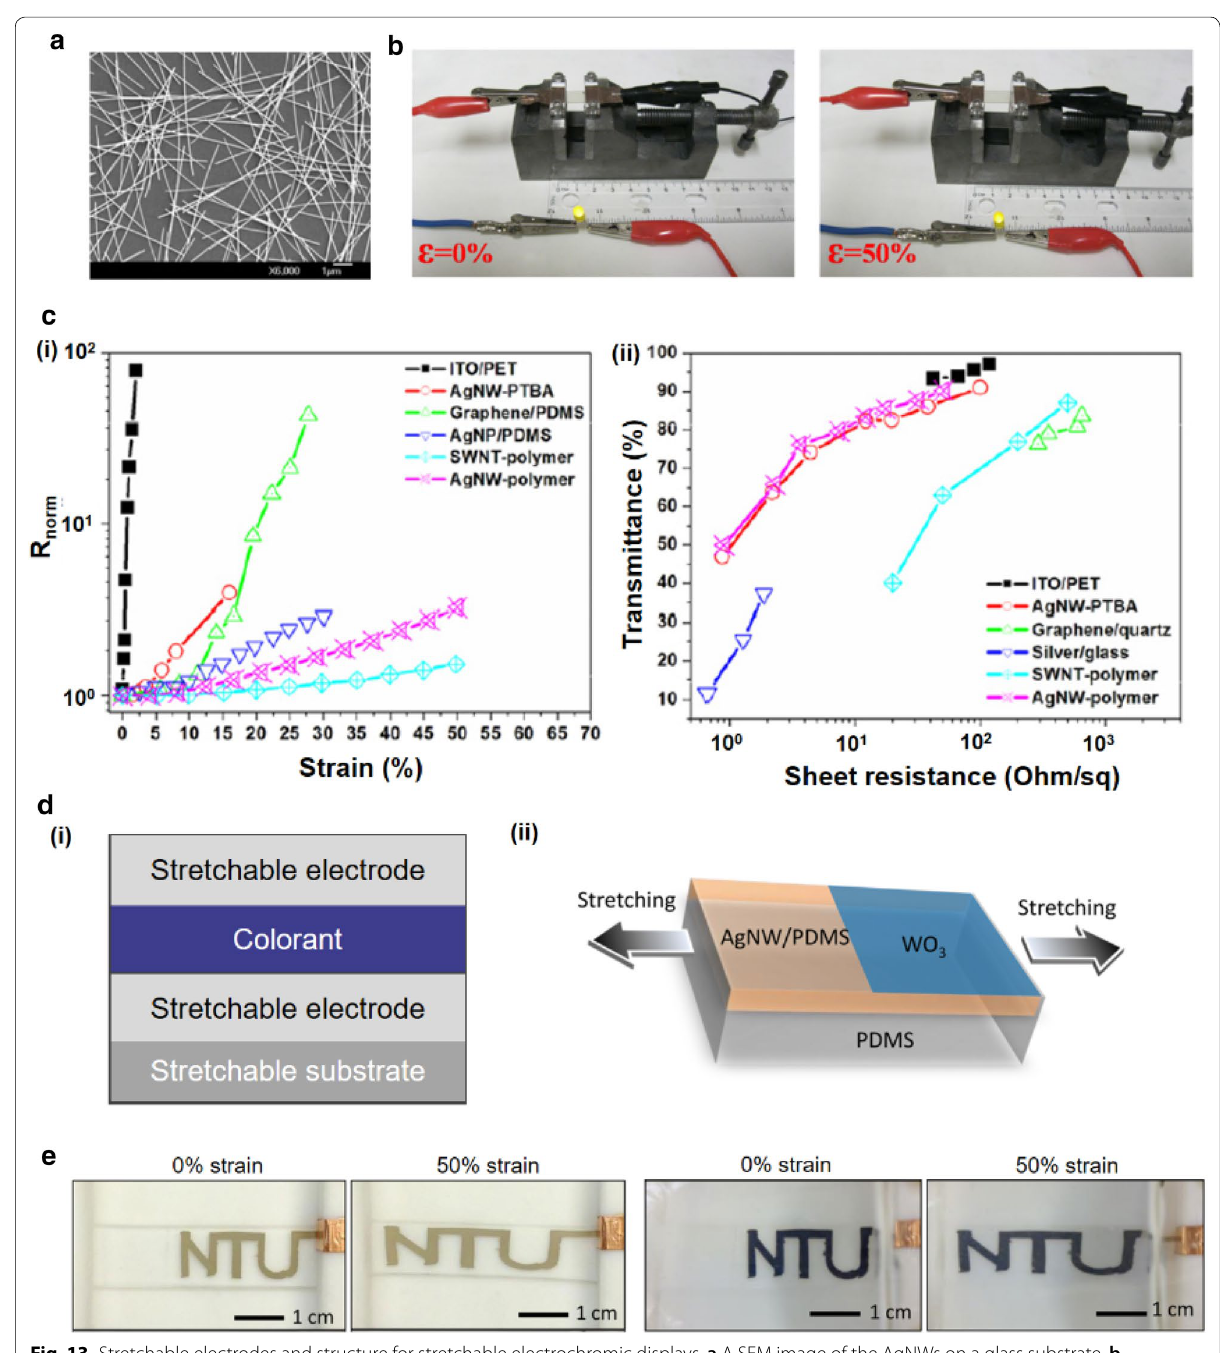
Fig. 13 Stretchable electrodes and structure for stretchable electrochromic displays. a A SEM image of the AgNWs on a glass substrate. b Stretchability of a AgNW electrode is demonstrated with a light‑emitting diode. c Electrical and optical properties of stretchable electrodes. (i) Normalized resistance as a function of applied strain. (ii) Transmittance versus sheet resistance. d (i) Possible structure of the stretchable electrochromic device. (ii) An example with AgNW/PDMS and WO 3 . e Patterned electrochromic device in bleached and colored states at 0 and 50% strain (Figure reproduced from a – c [92], Copyright 2012, IOP Publishing Ltd; d (ii) and e [94], Copyright 2013, America Chemical